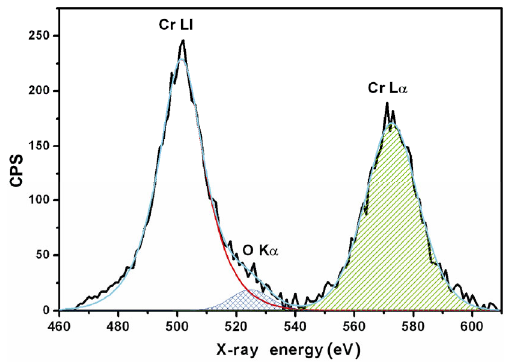
Fig. 3 WDSX spectrum of the as-deposited sample 1. Peak deconvolution shows (shaded areas) the relative proportion of oxygen and chromium.